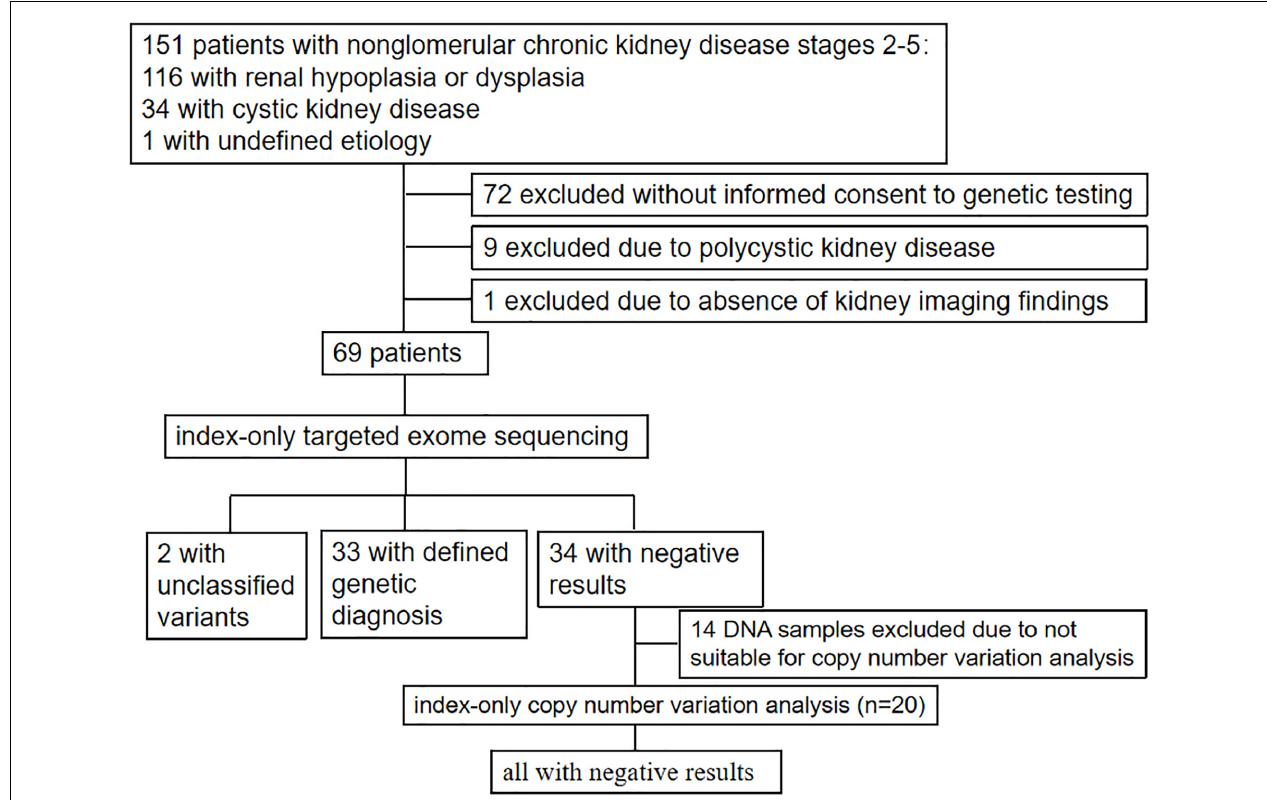
FIGURE 1 | Flow diagram for patient selection and genetic